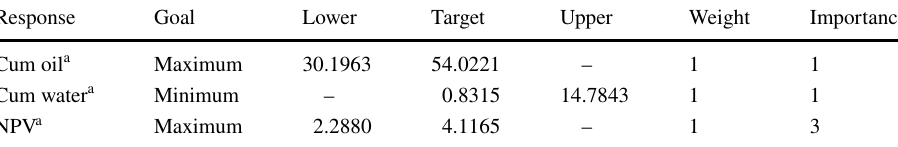
a Cum oil: cumulative oil production/ Cum water: cumulative water production/ NPV: net